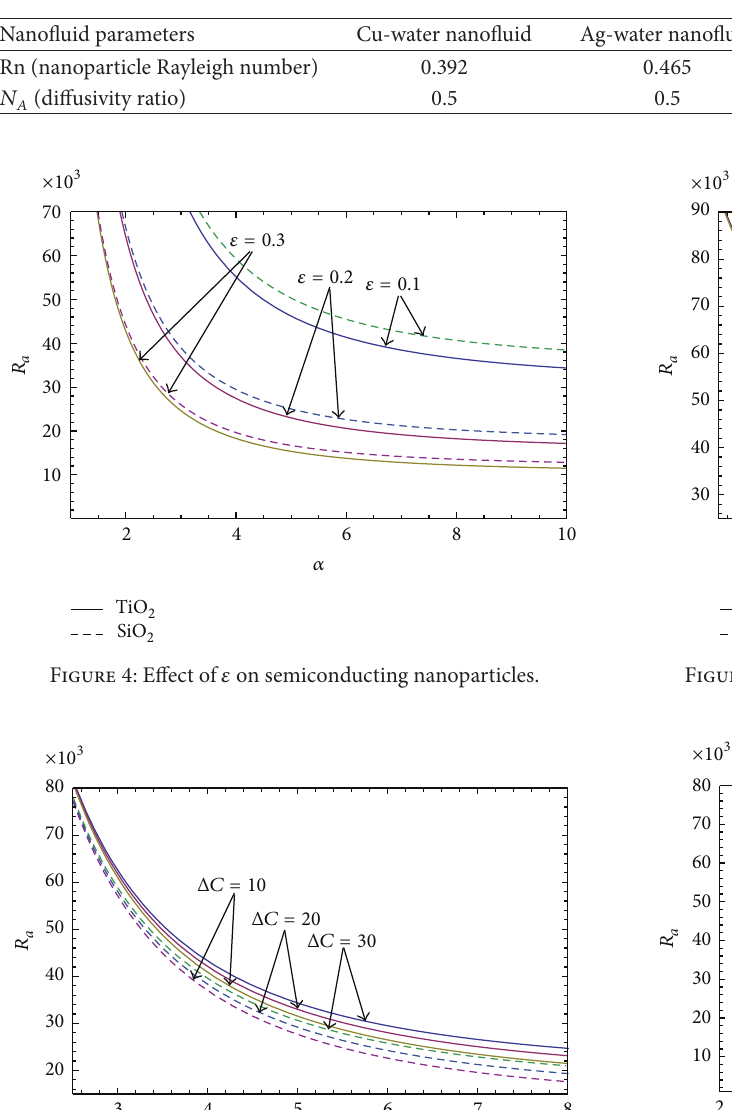
Table 2: Nanofluidparameters for metallic/nonmetallic nanoparticles in water based nanofluids under consideration.